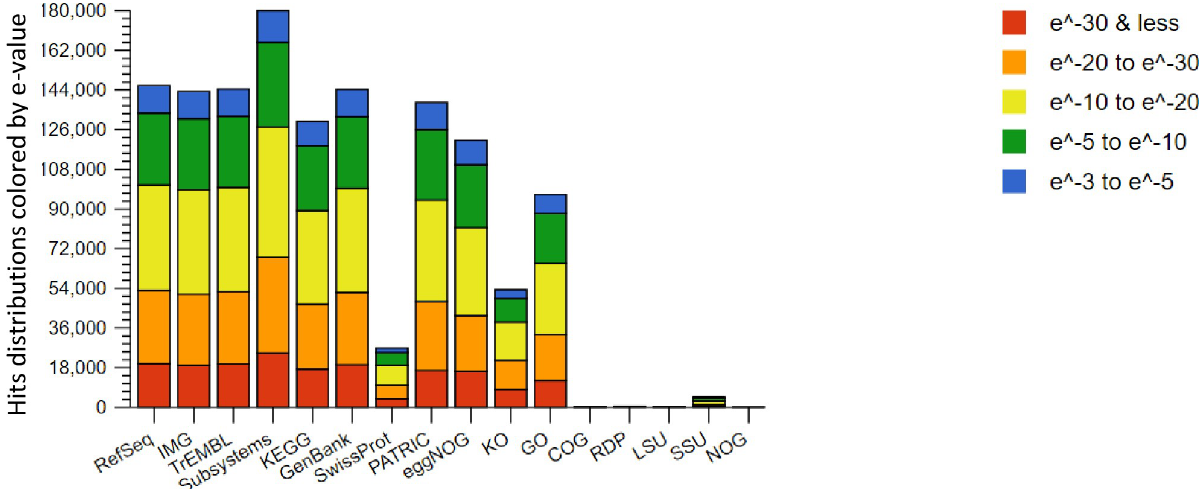
Fig 1. Stacked barchart showing the sources of hits distributions from the sixteen databases. These include nucleotide and protein databases, protein databases with functional hierarchy information, and ribosomal RNA databases. The bars representing annotated reads are colored by e-value range. Different databases have different numbers of hits but can also have different types of annotation